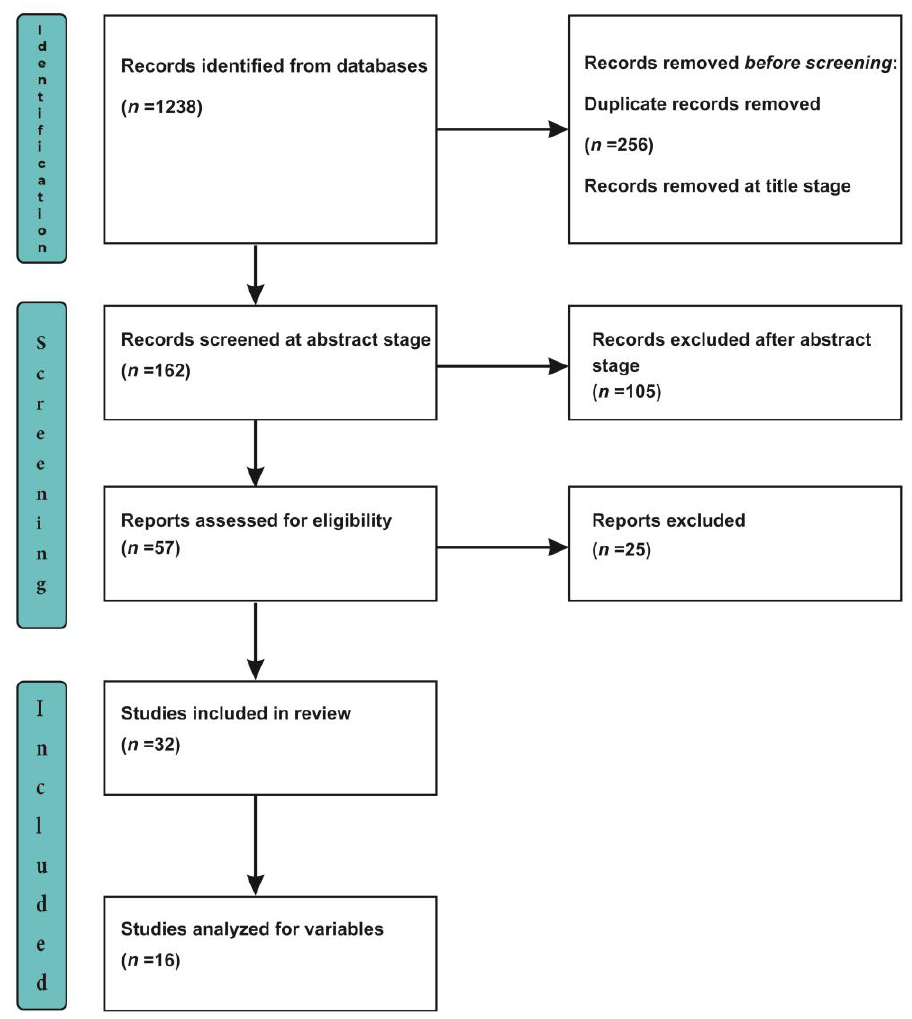
Figure 1. PRISMA Figure 1. PRISMA Flowchart.